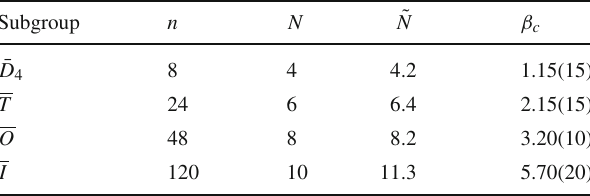
Table 4 β c -values for the discrete subgroups of SU ( 2 ) . N are the exact cyclic orders and ˜ N are approximations according to Eq.